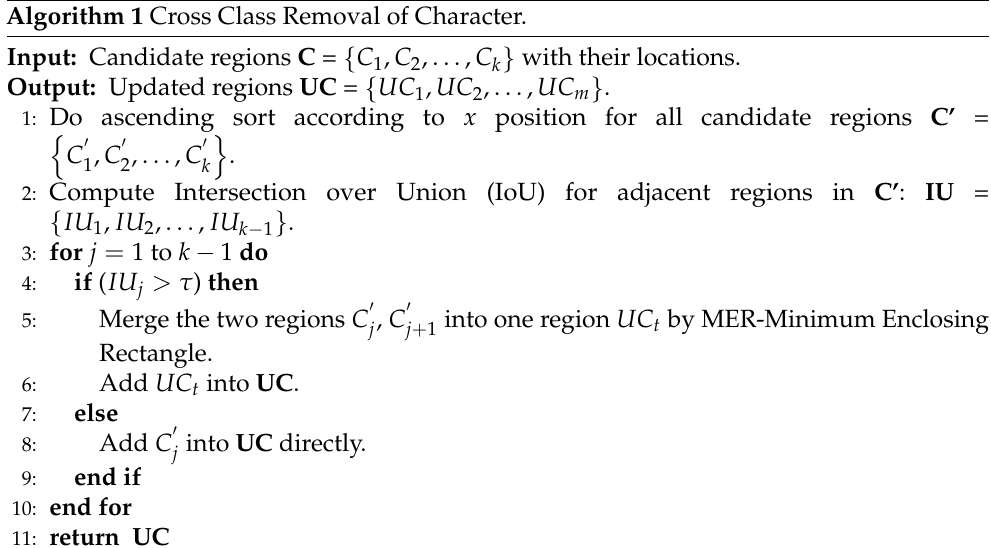
Algorithm 1 Cross Class Removal of